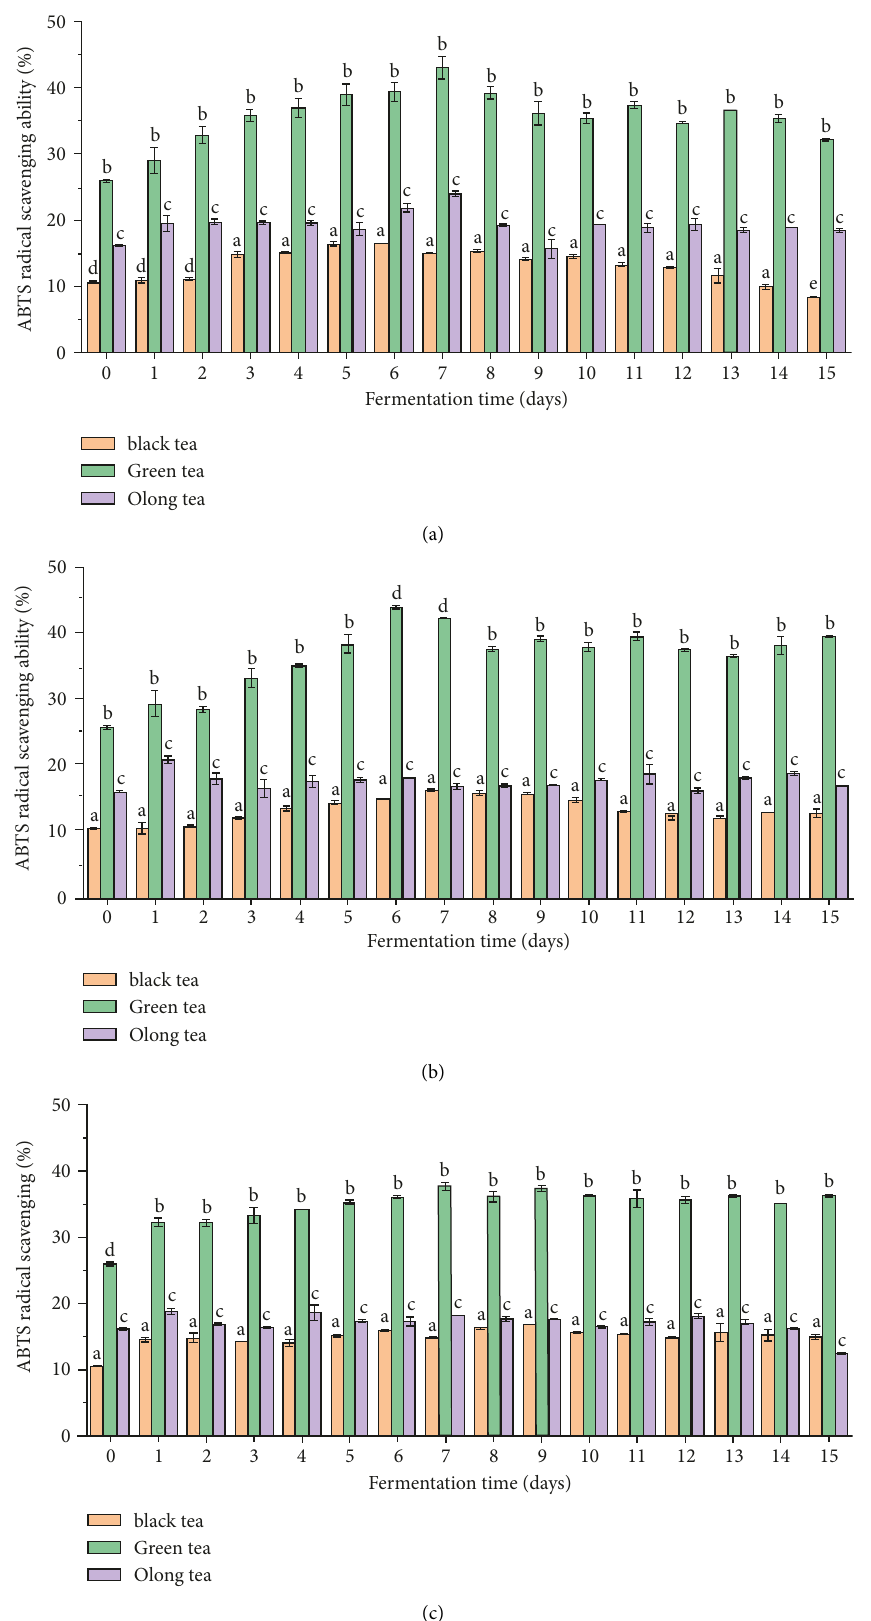
Figure 2: Changes in antioxidative activity of kombuchas fermented from three different teas at different temperatures ((a) 35 ° C; (b) 30 ° C; (c) 25 ° C) measured by ABTS radical scavenging ability. Different letters in the same graph indicate significant difference ( P < 0 .